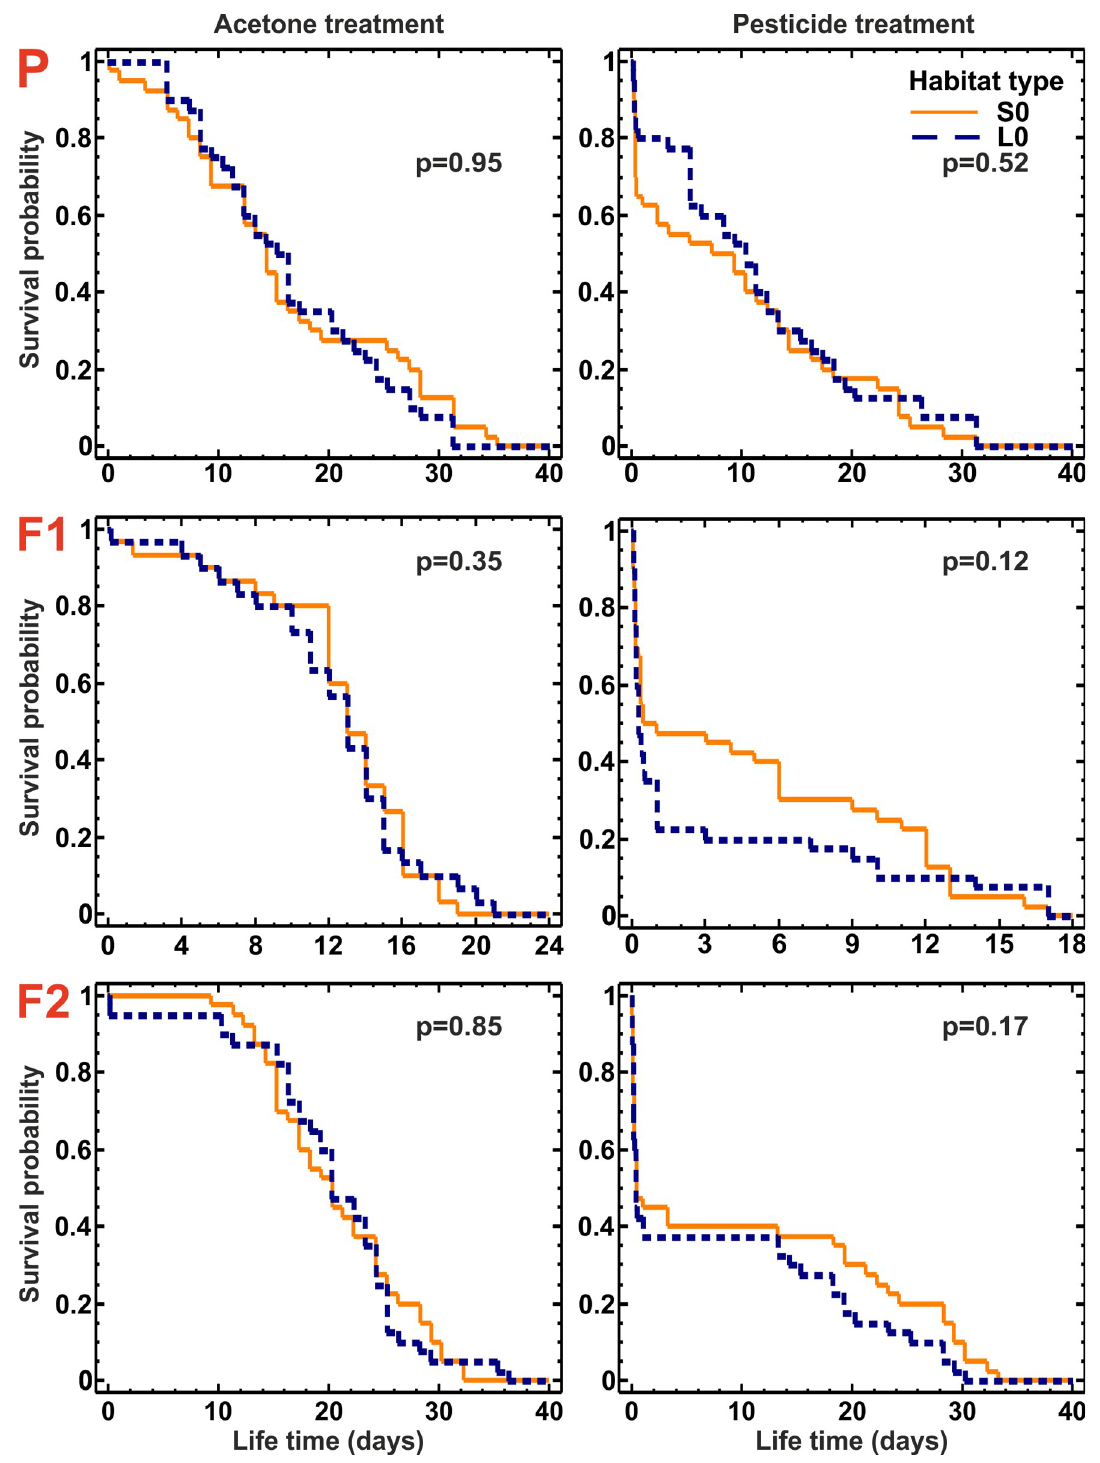
Fig 2. Survival curves of all three generations of Poecilus cupreus from control habitats after exposure to acetone and Proteus 110 OD pesticide treatment. Solid lines stand for small-fields landscape; dashed lines stand for large-fields landscape. The first character stands for landscape type: S–small fields landscape, L–large fields landscape; the second character stands for canola coverage: 0 –none. Red uppercase letters indicate generations: P–parental, F1 & F2 –laboratory breed. In all three generations the insecticide treatment significantly increased the mortality rate (p < 0.0001); p values on the graphs indicate the significance level for comparisons between S0 and L0 beetles. https://doi.org/10.1371/journal.pone.0266453.g002 PLOS ONE | https://doi.org/10.1371/journal.pone.0266453 April 26,